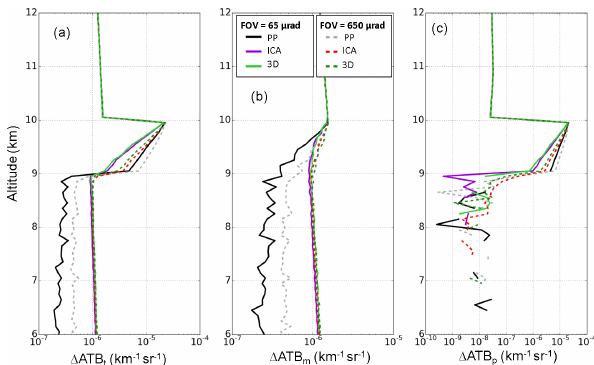
Figure 16. Same as Fig. 13 but with 50% cloud coverage. Simula- tions with ATLID FOV (65µrad) are represented by full lines and simulations with a 650µrad FOV are represented by dotted